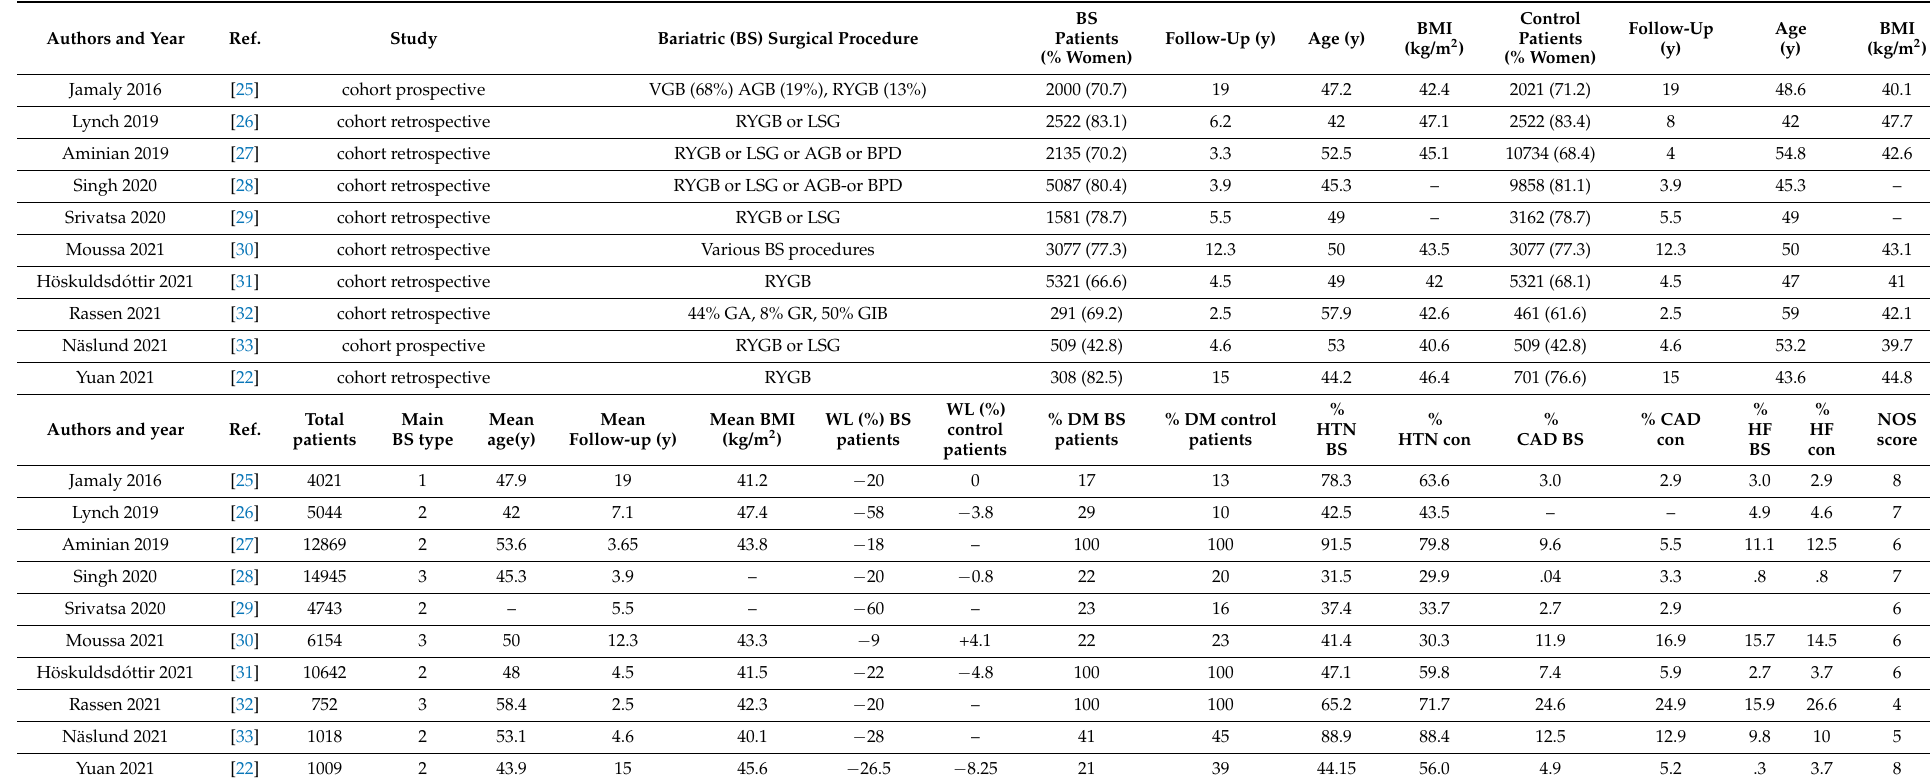
Table 1. Details of the studies